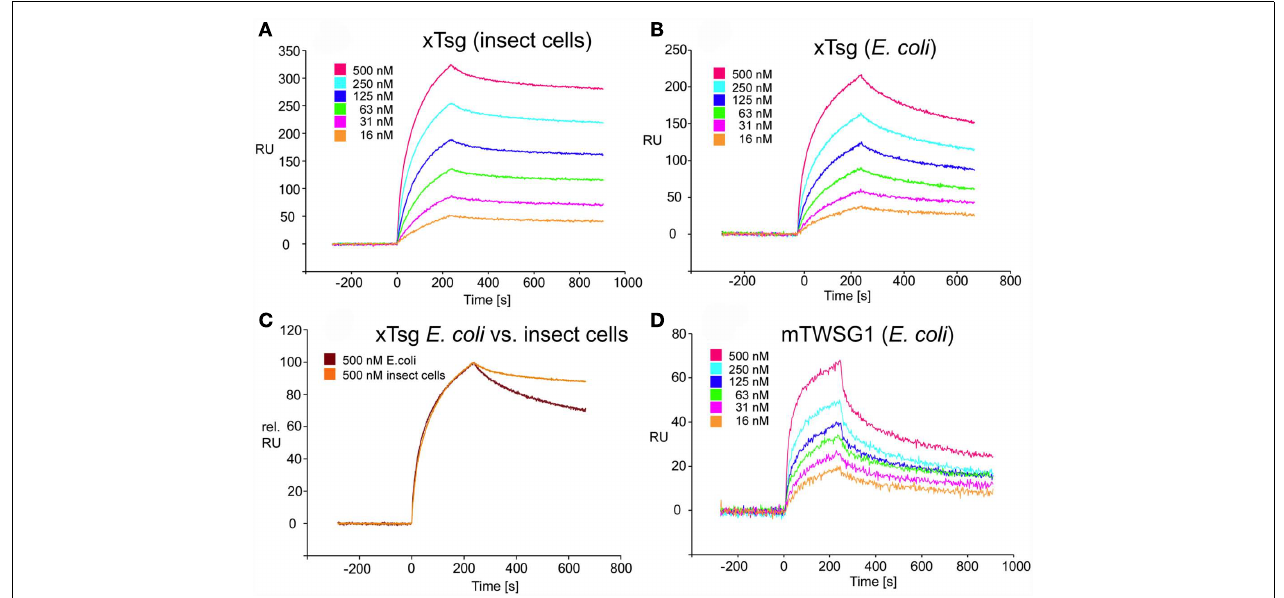
derived from expression in insect cells or (B) xTsg produced in E. coli . ( C )The different dissociation rate constants between xTsg protein derived from either a eukaryotic or a prokaryotic host is apparent from an overlay of two normalized SPR sensorgrams recorded for the interaction of different xTsg proteins (500nM concentration) with BMP2. (D) The interaction of mTWSG1 derived from E. coli expression reveals a biphasic interaction with BMP2.The binding kinetics following a slow association and a slow dissociation yields an equilibrium binding constant very similar to that of xTsg produced in bacteria .